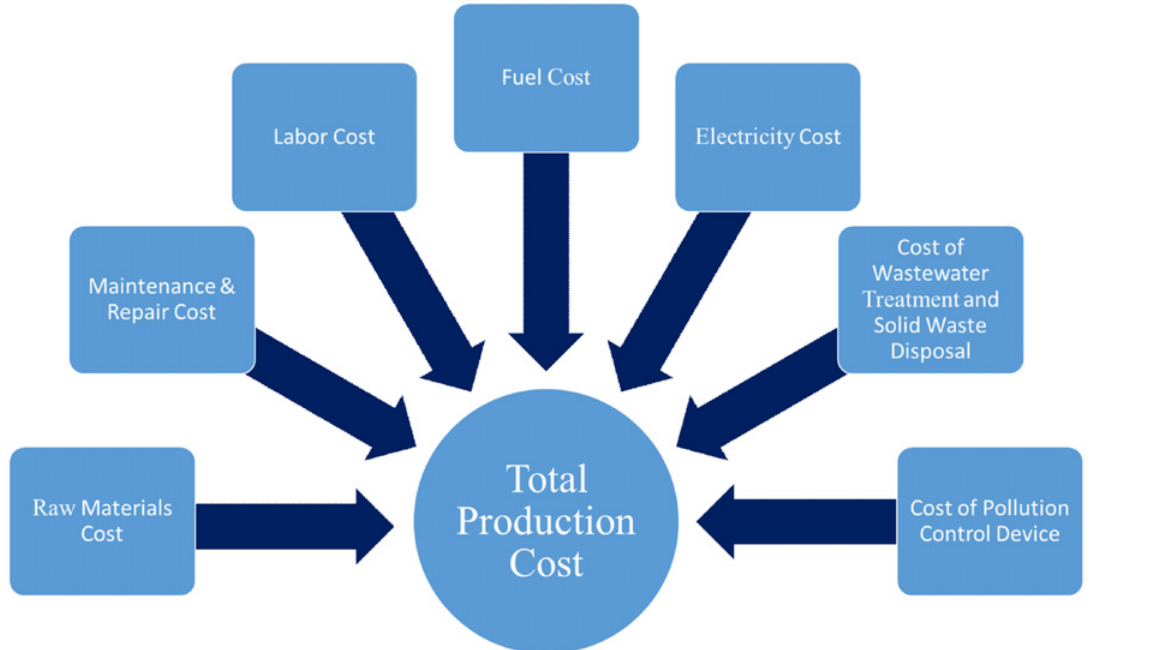
Fig 9. Different cost components used in ISIS model for performing production cost